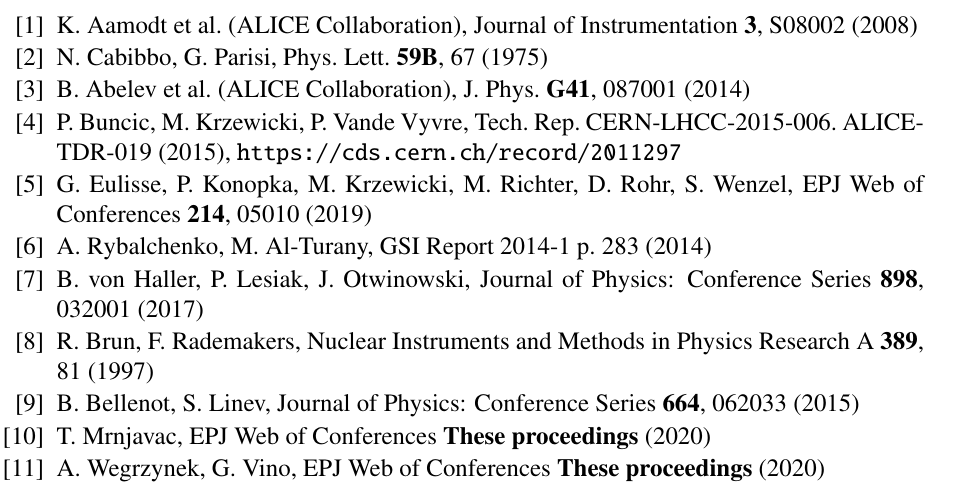
10% of the system and later on the full system. The Quality Control software will play an important role there as a tool to quickly identify possible problems with the data itself and indirectly with the detectors and data